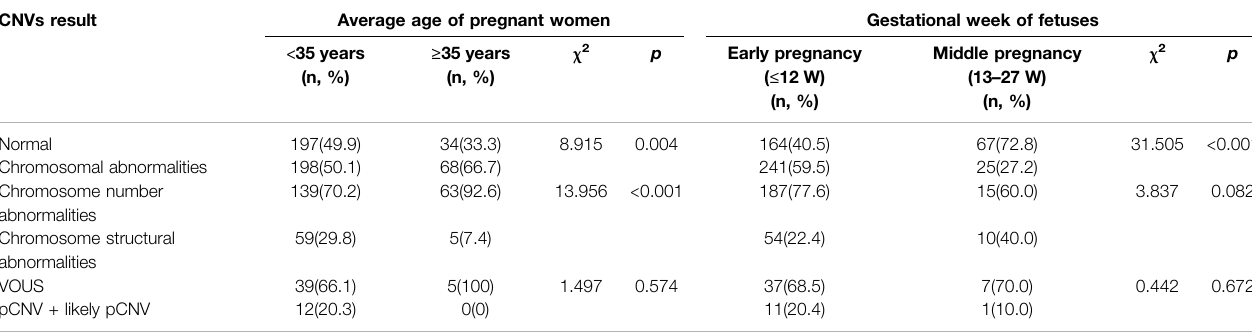
TABLE 2 | Comparison of CNVs results among different age pregnant women and gestational week of fetuses. CNVs